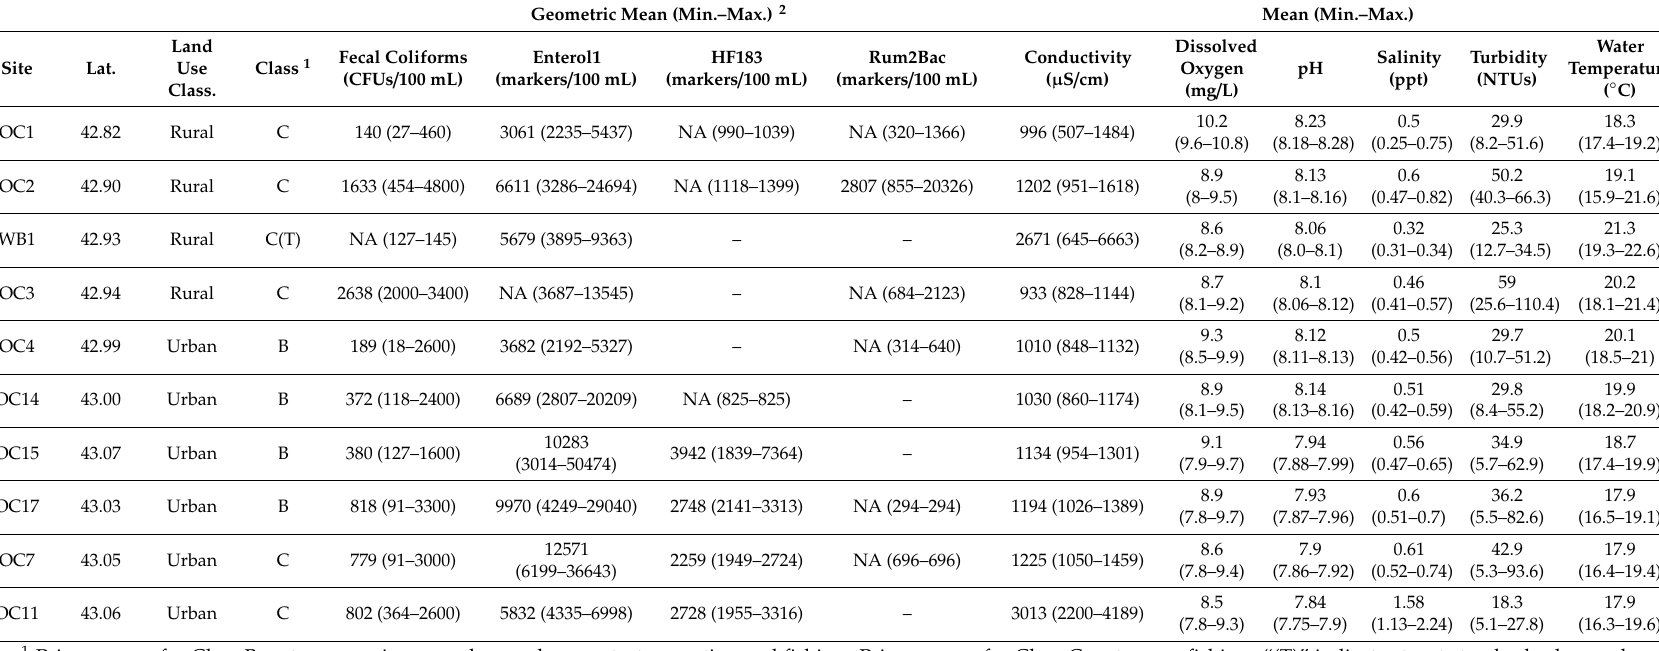
Table 2. Summary of microbial and physical–chemical water quality for each site during the study